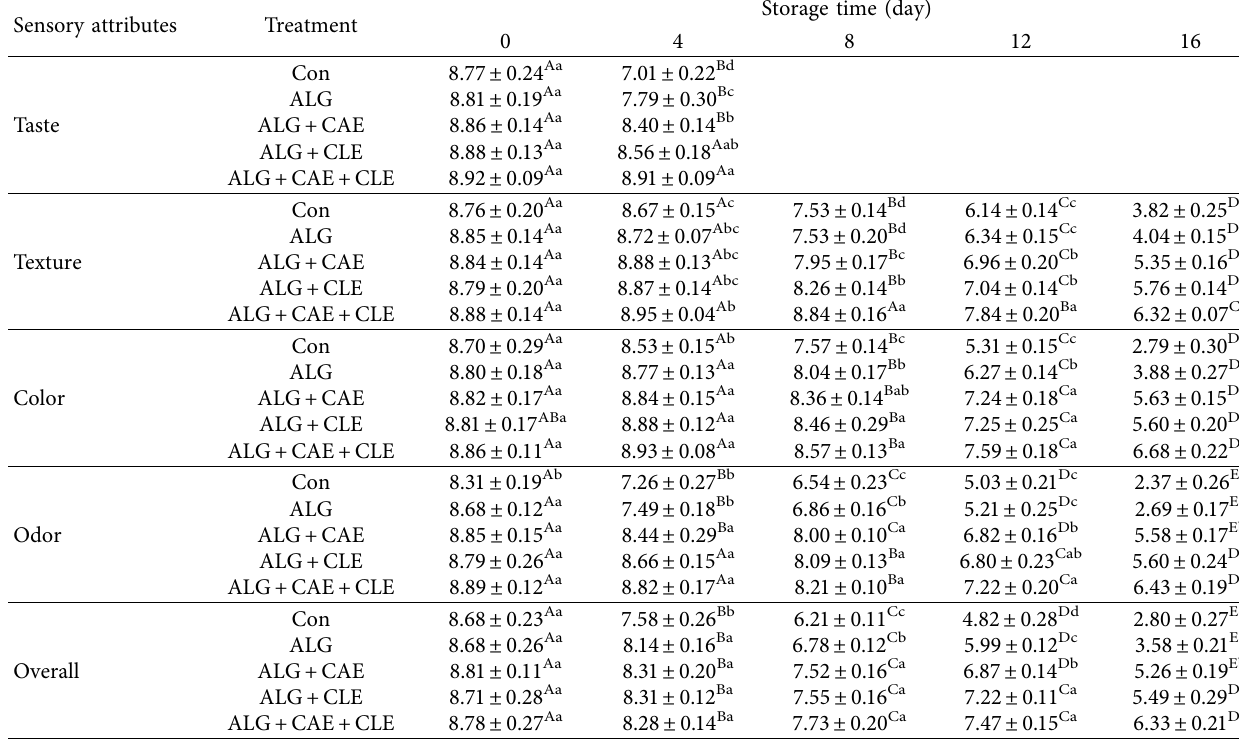
Table 1: Changes in sensory properties of chicken fllet samples during refrigerated